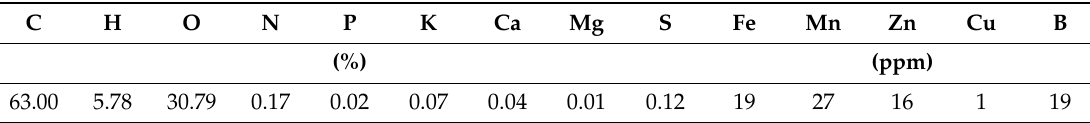
Table 1. Element analysis results of Kraft lignin